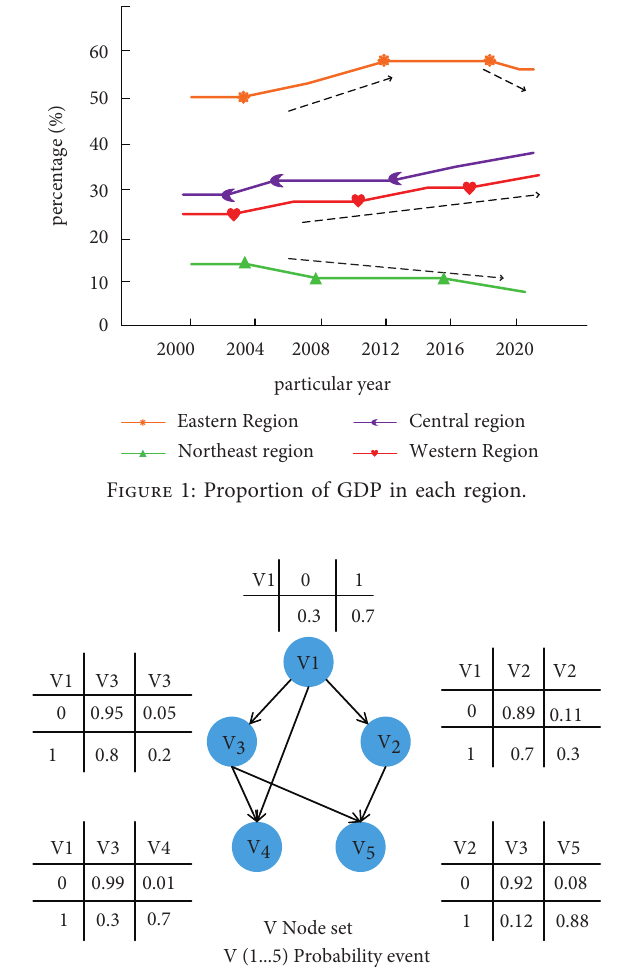
Figure 2: Bayesian network model